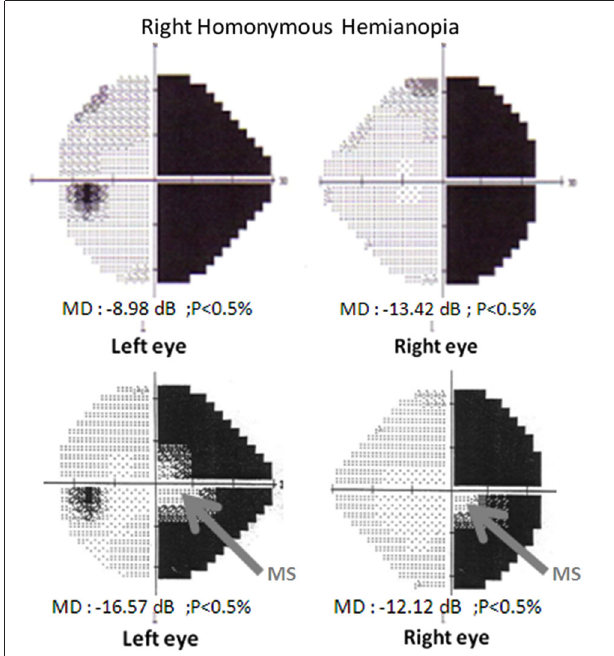
FIGURE 1 | Visual-field examination (Humphrey automated perimetry, 24-2, SITA-FAST program) . Top: Right homonymous hemianopia without macular sparing. Visual fields of the left and the right eye. Bottom: Right homonymous hemianopia with macular sparing. Visual fields of the left and the right